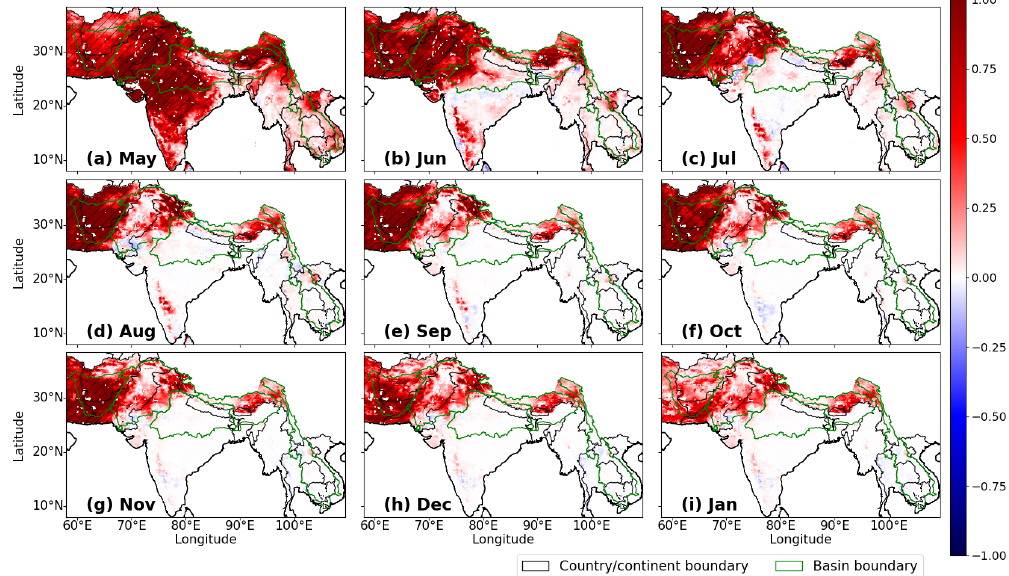
Figure 7. Inter-annual correlation difference of root zone soil moisture (1m) between hindcast simulations using real initial condition (RIC) and climatological initial condition (CIC) against the retrospective simulations. The difference is computed as the correlation of RZSM between hindcast simulations and retrospective simulations minus the correlation between hindcast simulations and retrospective simulations. The hatched areas denote the statistically significant correlation difference at 0.95 confidence level.